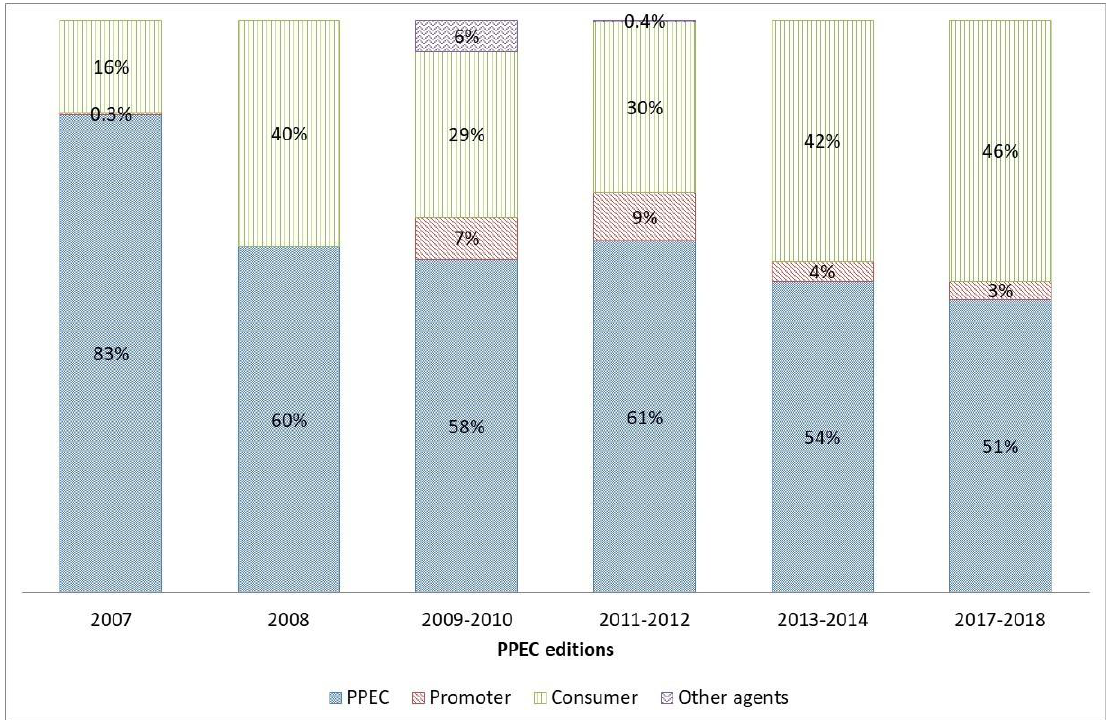
Figure 10. Share of societal costs of the selected tangible measures for the Commerce and Services consumption segment, in each PPEC edition [19–26].